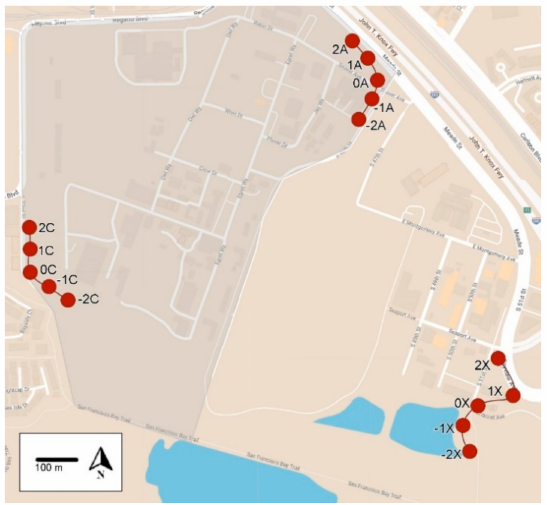
Figure 2. Map of the UC Berkeley Richmond Field Station showing the locations of the three monitoring transects used during 2021. Baits were applied along transect A. Transects C and X were untreated and considered seasonal checks (controls). Red dots indicate the location, and the number of the monitoring trap along transects A, C and X. Minimum distance from transect A to C—800 m; minimum distance from transect A to X—700